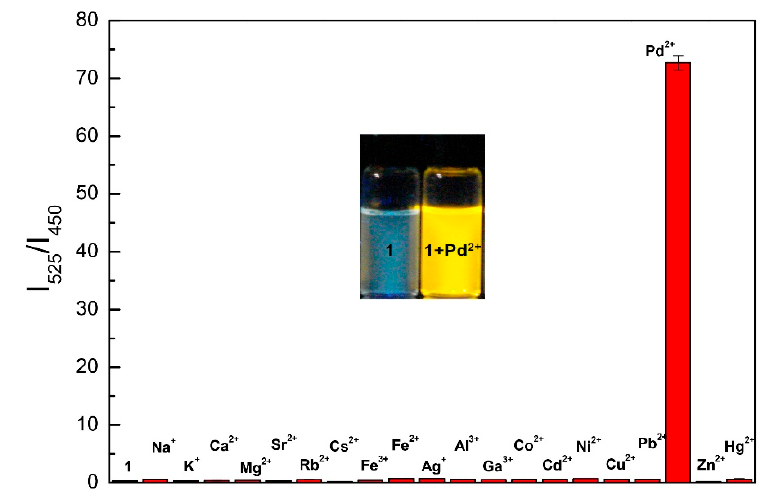
Figure 1. Fluorescence intensities ratio ( I 540 / I 390 ) of 1 (1.0 μ M) with different cations (10 equivalents) in H 2 O:DMF (9:1) containing HEPES buffer (10 mM, pH 7.4). ( λ ex = 330 nm). Inset: fluorogenic change from blue to yellow fluorescence upon illumination at 365 nm.